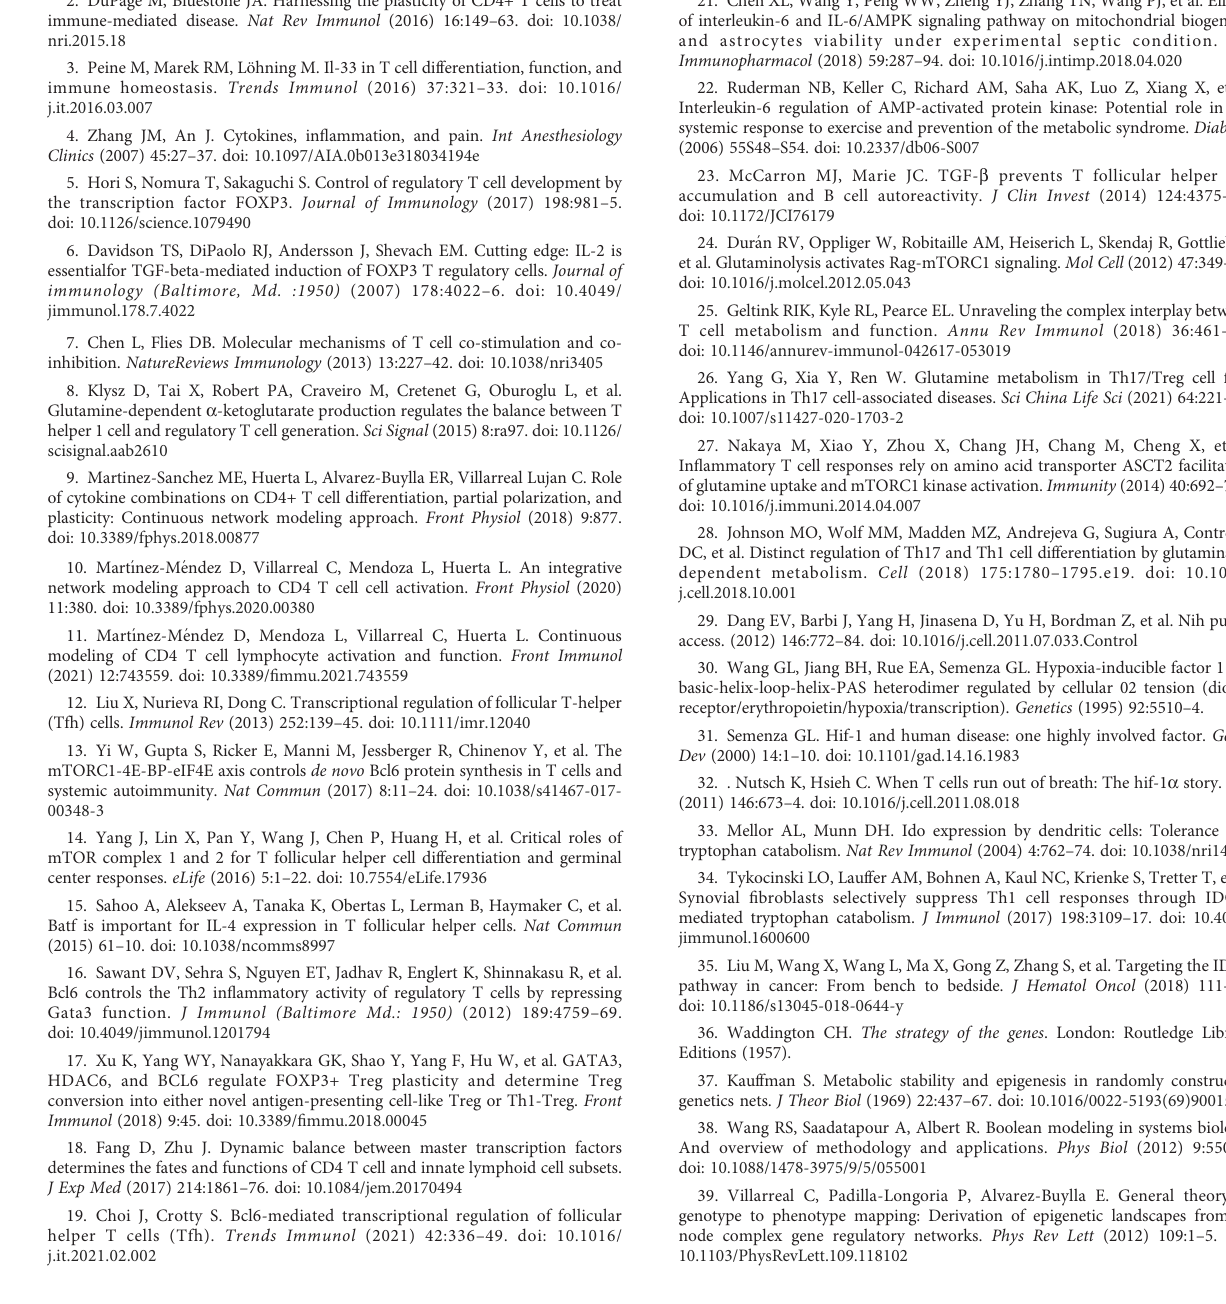
SUPPLEMENTARY FIGURE 1 Phenotype expression in a microenvironment de fi ned by depleted levels (0.70) of a uniform mixture of all-type of exogenous cytokines, under optimal nutrient and oxygen conditions (as indicated in histograms). (A) When all exogenous cytokines are present a predominant Th17 phenotype is induced. (B) Absence of IL-6 prompts the manifestation of the Treg phenotype. (C) Absence of TGF- b induces a low level TFH phenotype.